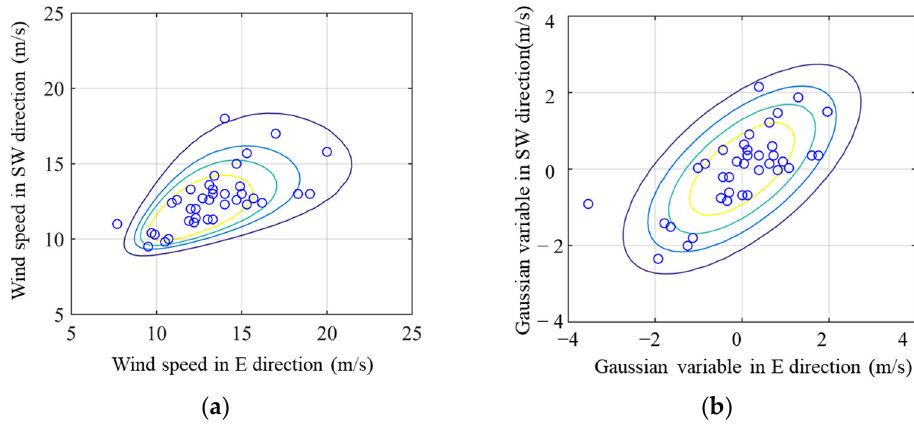
Figure 2. Dependence structure pattern and contour of JPDF of yearly maximum mean wind speeds between E and SW directions in Jinan, China: ( a ) Wind speed; ( b ) Gaussian variable. Figure 3 shows the CDF of non-directional yearly maximum mean wind speed Ψ v , as determined by the multivariate extreme model through Gaussian copula. On the basis of the assumption that the mean wind speeds in different wind directions are independent and fully correlated, the CDFs are, respectively, denoted as Ψ v , ind . and Ψ v , fullcor . , as shown in the same figure. It can be seen clearly that Ψ v is close to one assuming independent Ψ v , ind . This is especially evident for higher wind speeds. For a given MRI, the CDF of yearly maximum mean wind speed, as obtained by means of the fully correlated assumption Ψ v , fullcor . , is smaller than Ψ v and Ψ v , ind . . The 25- and 50-year non-directional mean wind speeds obtained by using the multivariate model Ψ v are 21.3 and 22.8 m/s, respectively, which is consistent with the red dashed and solid circles in Figure 1a. As shown in this figure, the non-directional wind speed exceeds the largest directional yearly maximum mean wind speed given the same MRI. This is attributed to the three dominant wind directions with a comparable wind speed, i.e., E, NW, and S, as well as the weak correlation between them, as shown in Table 1.